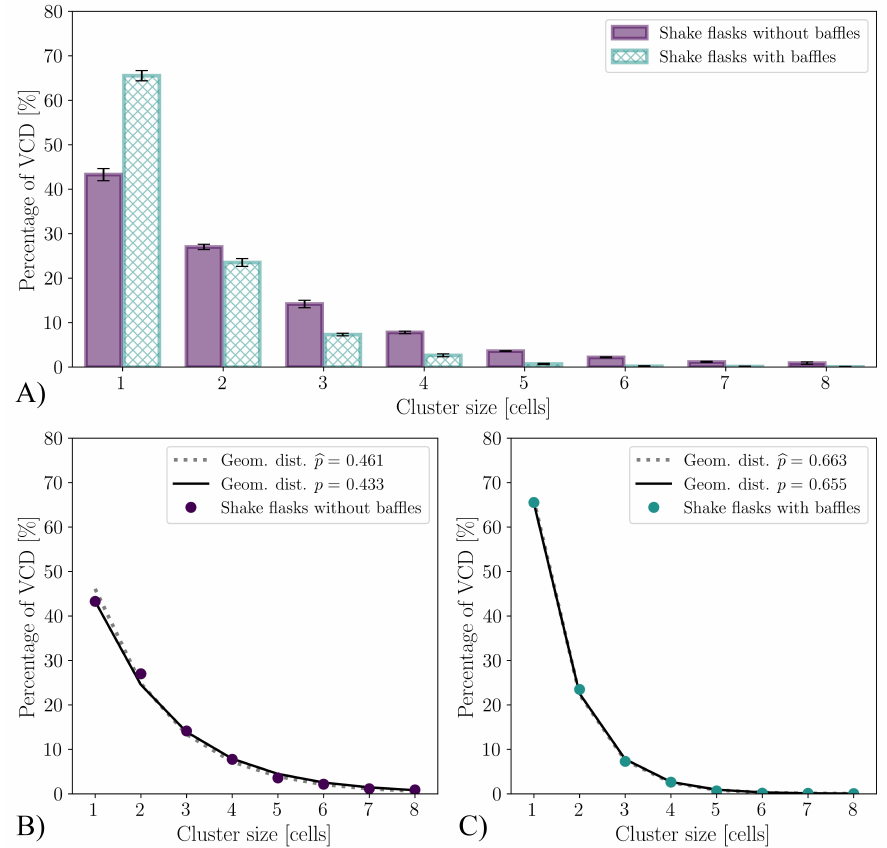
Figure 5. Cluster size distribution at the cultivation time, at which the VCD is maximum t VCD ( A ) Comparison of the cluster size distribution for the cultivations with the two different shake flask configurations. ( B , C ) show the size distribution measured and approximated by the geometric distribution. The geometric distribution where parameter p is equal to the proportion of non- aggregated viable cells is shown as a solid line. The dashed line, in contrast, shows the geometric distribution with parameter p that is determined by the maximum likelihood estimation ˆ p